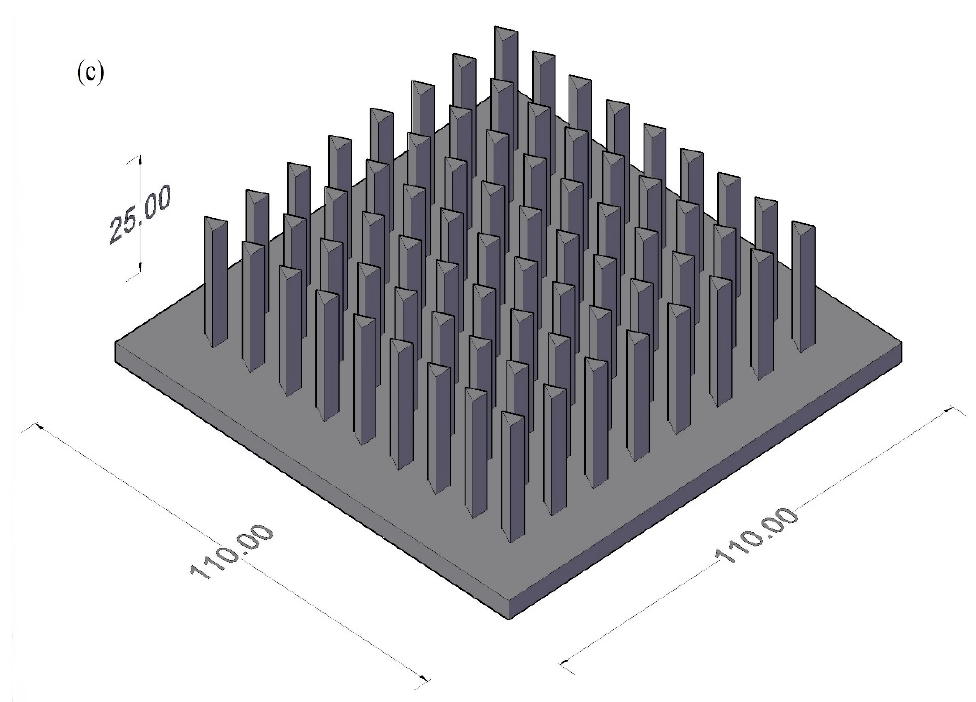
Figure 2. Heat sinks isometric views ( a ) circular, ( b ) square, and ( c ) triangular pin fins.